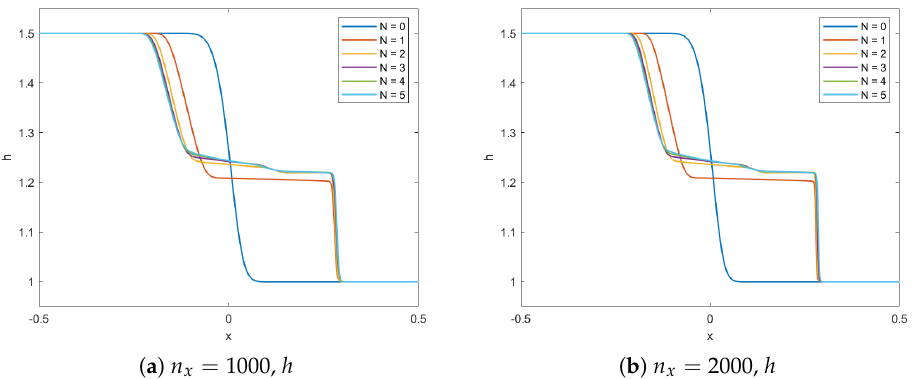
Figure 15. Dam break test case water height using PFE scheme for different N and two different grids using n x = 1000 ( a ) and n x = 2000 ( b ) for constant λ = 10 − 4 shows that the solution is converged. Table 6. Dam break test case runtime and speedup using FE and PFE schemes for different N and constant n x = 2000, λ = 10 − 4 shows significant speedup close to the theoretical prediction. N